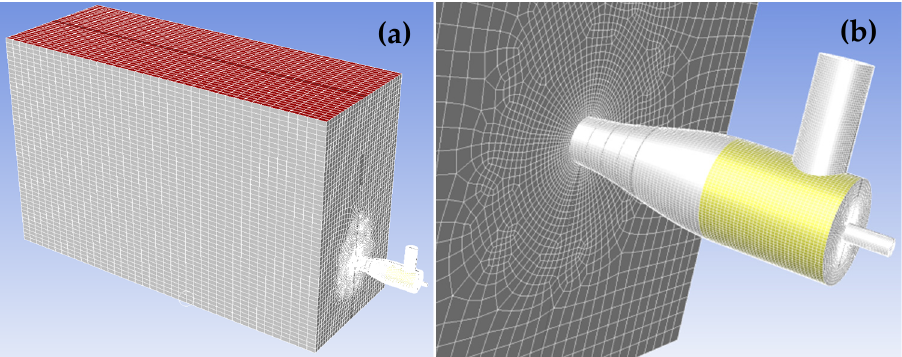
Figure 3. Meshing diagram of nozzle and observation tank. ( a ) Combined meshing diagram of observation tank and annular jet nozzle. ( b ) Meshing diagram of annular jet nozzle.